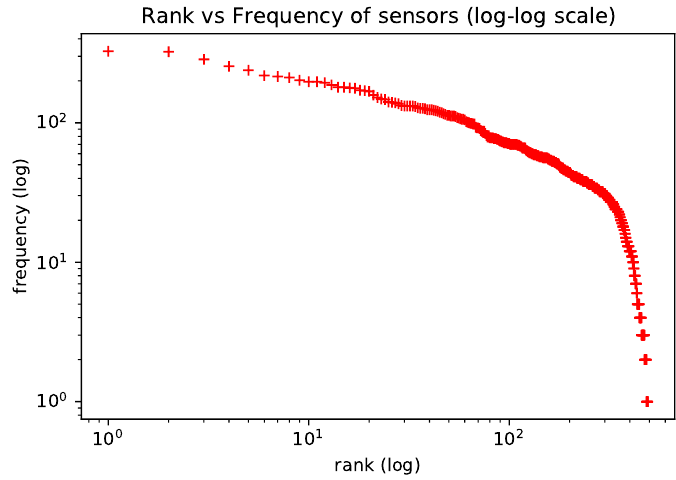
Figure 3. Statistics of sensor observations satisfy Zipf’s